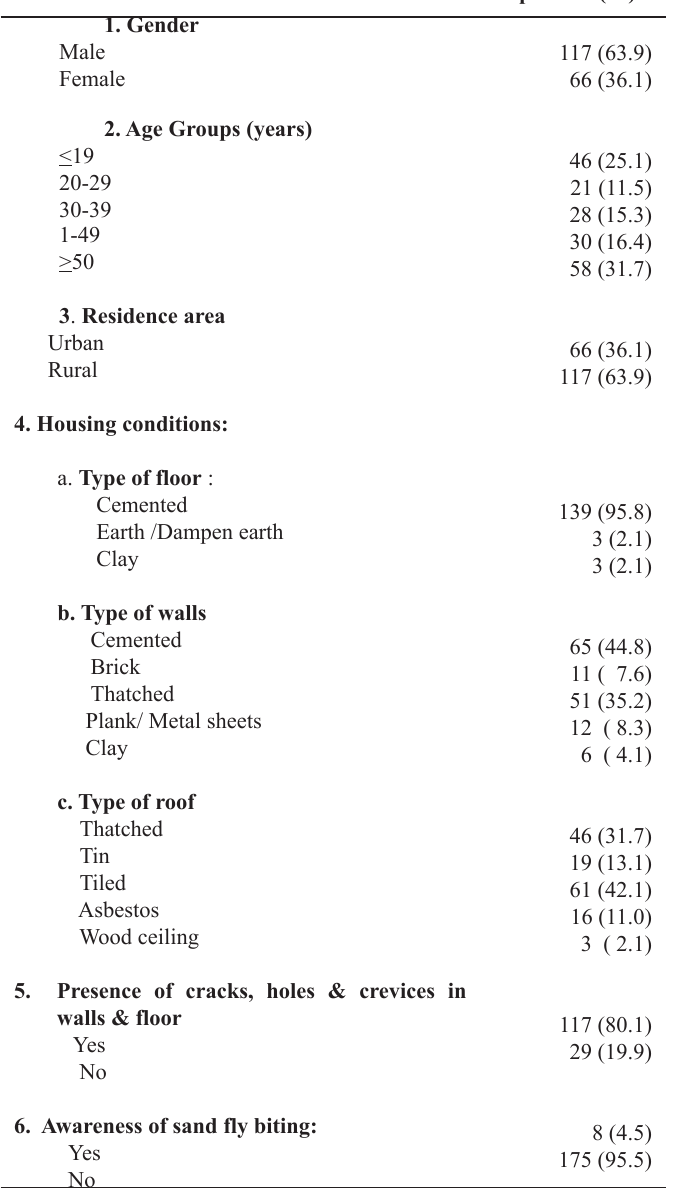
Table 2: Socio-demographic factors of CL positive patients in Hambantota district, Sri